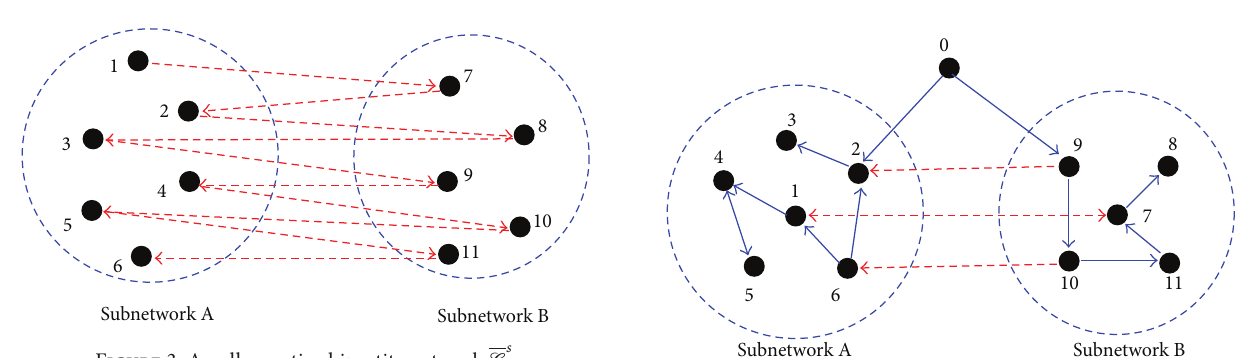
Figure 3: An all-negative bipartite network G